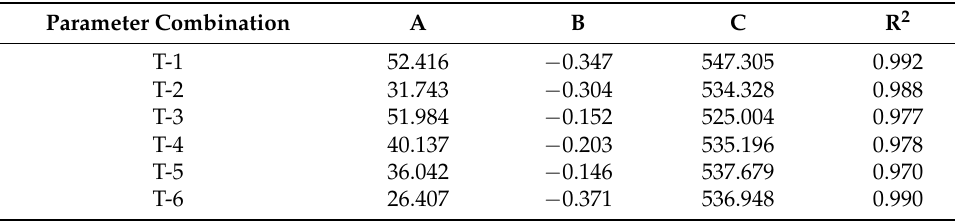
Table 11. Attenuation parameter of stationary steering resistance